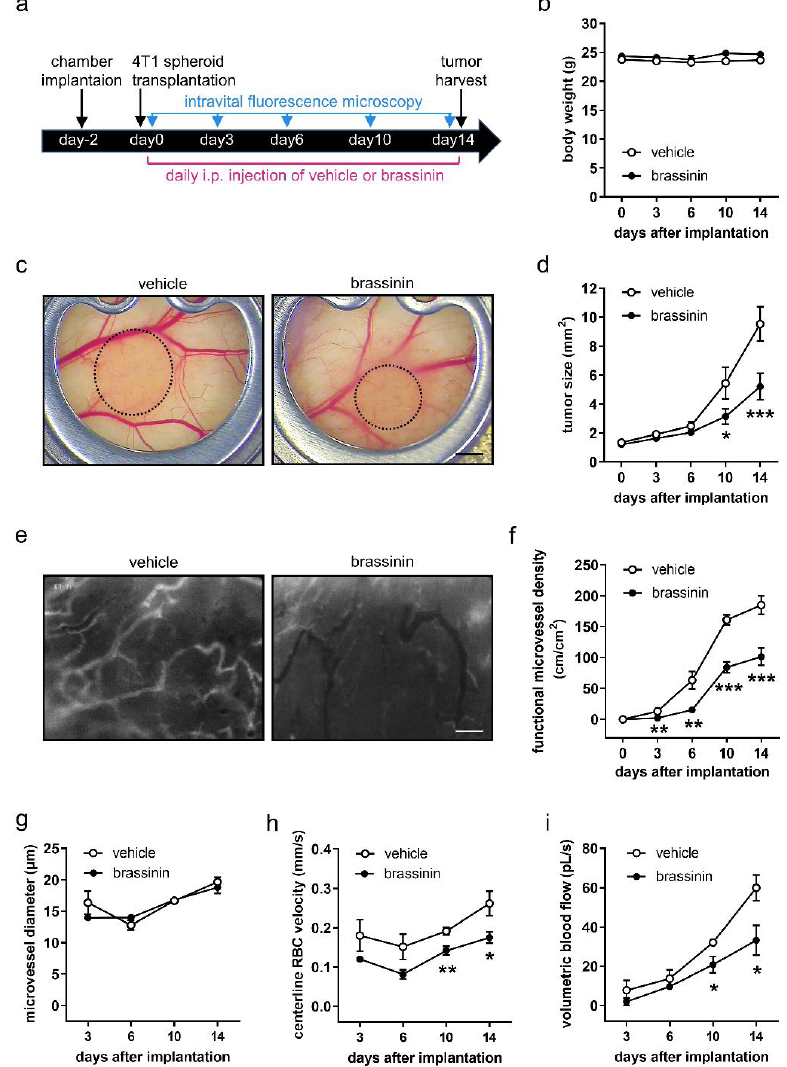
Figure 3. Brassinin inhibits TNBC growth and angiogenesis. ( a ) Timeline of the dorsal skinfold chamber model assessing the effect of brassinin on 4T1 tumor development. ( b ) Body weight (g) of vehicle- and brassinin-treated mice on day 0, 3, 6, 10, and 14 after spheroid transplantation ( n = 7). ( c ) Stereomicroscopy of 4T1 tumors (outlined with dashed lines) in the dorsal skinfold chamber of a vehicle- and a brassinin-treated mouse on day 14. Scale bar: 1.3 mm. ( d ) Size (mm 2 ) of 4T1 tumors on day 0, 3, 6, 10, and 14 after spheroid transplantation was measured ( n = 7). ( e ) Images of newly formed microvessels within a vehicle- and a brassinin-treated 4T1 tumor on day 14 after spheroid transplantation. Scale bar: 95 µ m. ( f ) Functional microvessel density (cm/cm 2 ) of 4T1 tumors was quantified ( n = 7). ( g – i ) Microvessel diameter ( µ m; g), centerline red blood cell velocity ( µ m/s; h) and volumetric blood flow (pL/s; i) of 4T1 tumors were measured ( n = 7). Means ± SEM. * p < 0.05, ** p < 0.01, *** p < 0.001 vs. vehicle at each time